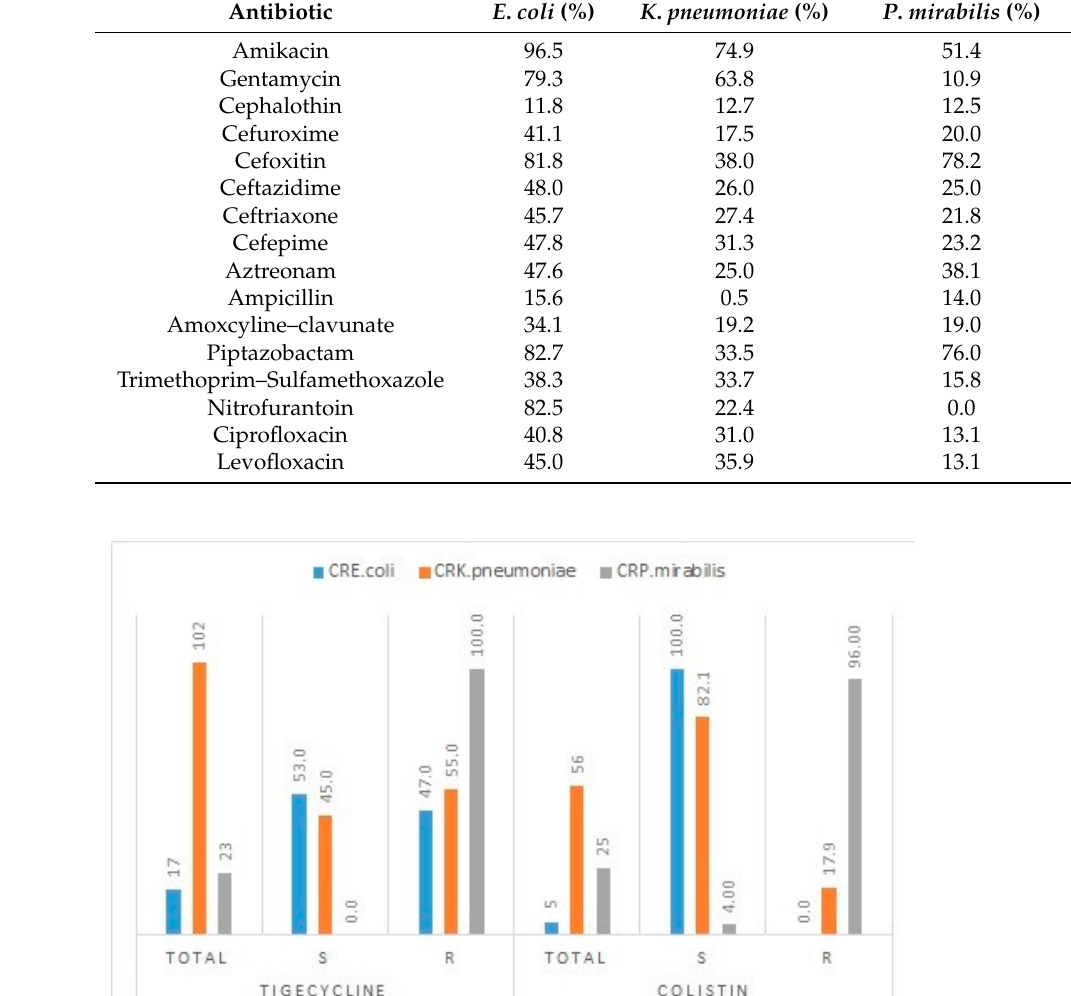
Table 5. Antimicrobial sensitivity of the studied organisms.